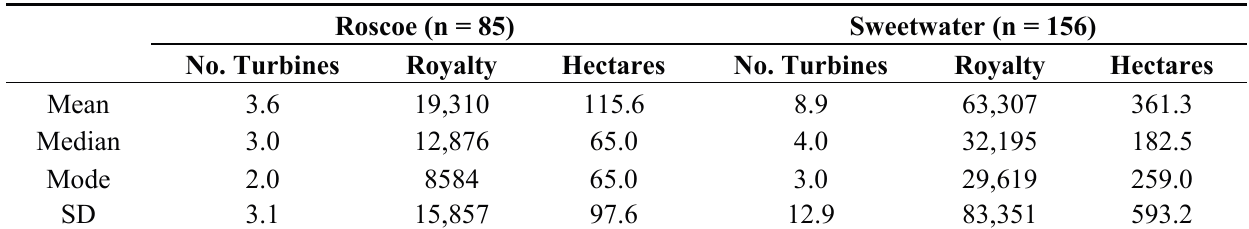
Table 4. Descriptive statistics for landholdings with turbines in the Roscoe and Sweetwater areas. Royalty column refers to estimated royalty per landholding per year.